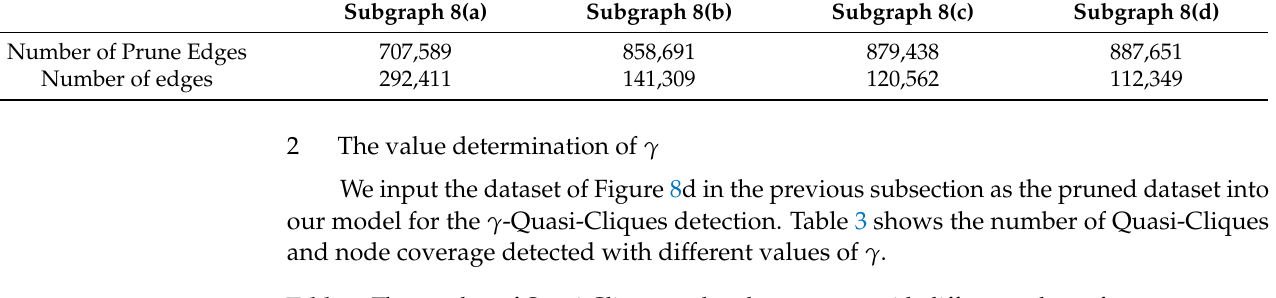
Table 3. The number of Quasi-Cliques and nodes coverage with different values of γ . γ = 0.6 γ = 0.7 γ = 0.8 γ = 0.9